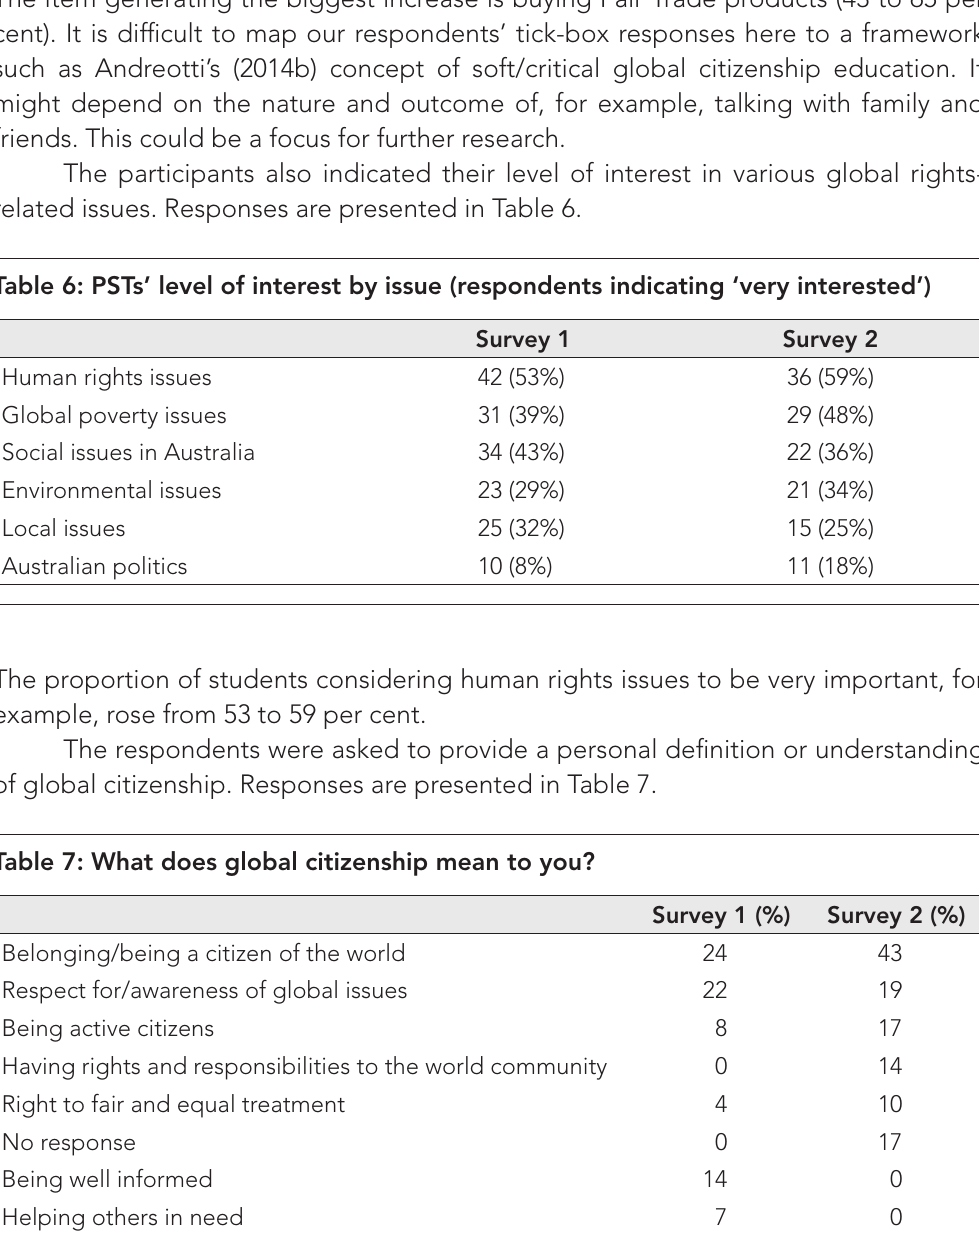
Survey 1 Survey 2 (% of respondents)